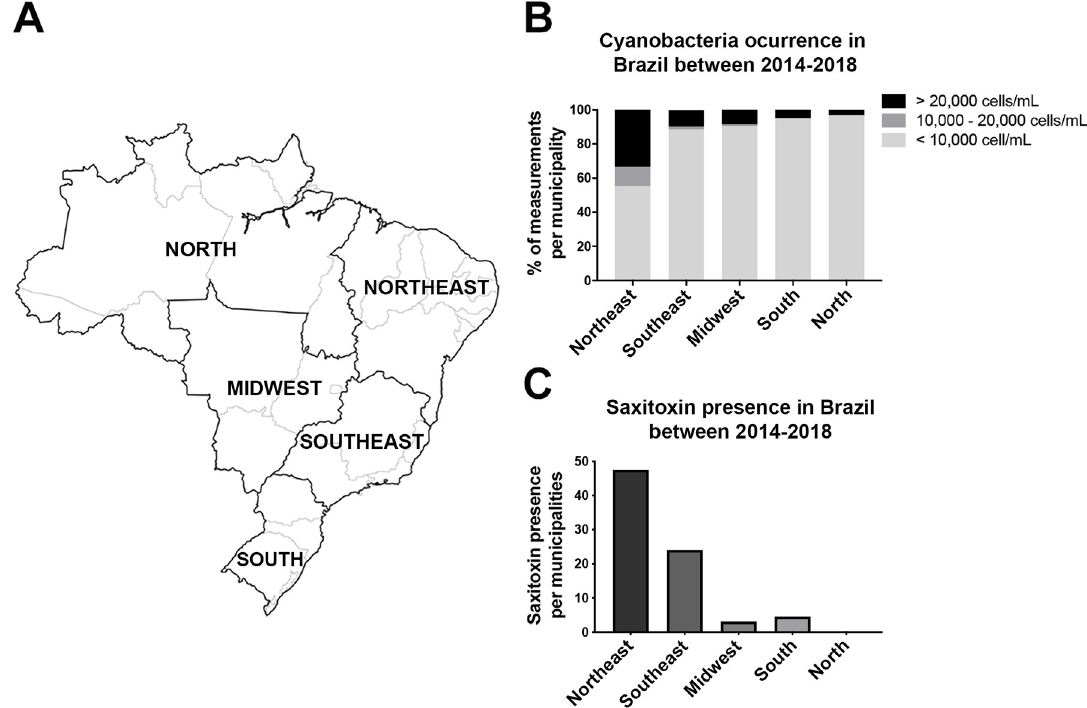
Fig 1. Cyanobacterial and STX occurrence among Brazilian Regions. (A) Brazilian map showing a division in regions. (B) Cyanobacteria in Brazil between 2014–2018. The measurements per municipality were split in ranges of cyanobacterial concentration. (C) STX 2014–2018 in Brazil. Note that NE had almost twice saxitoxin than